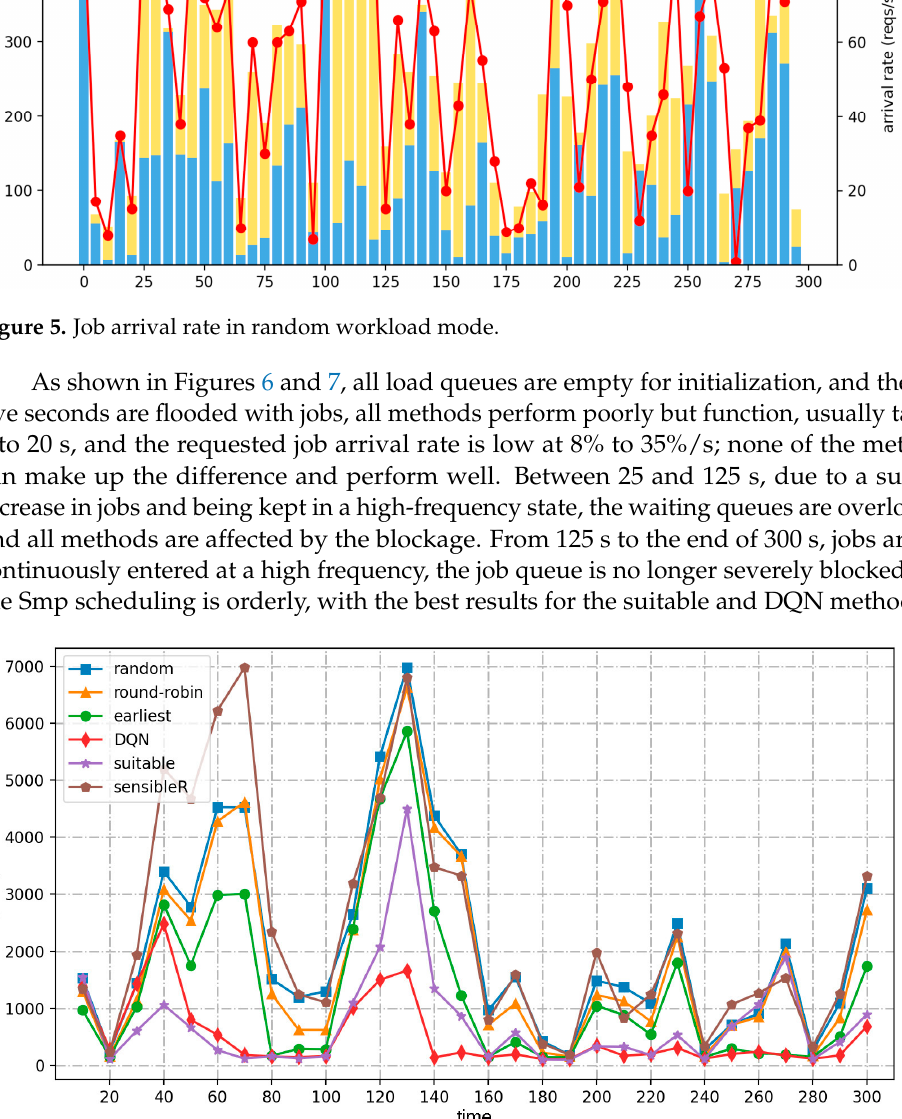
Figure 7. QoS s atisfaction in random workload mode. 5.3.2. Low-Frequency Workload Mode A low-frequency workload mode was set to test the algorithm’s performance in the Smp’s most common low-frequency idle usage scenarios. As shown in Figure 8, the job arrival rate for the low-frequency workload model was randomly generated in the range of [20,40] with a mean of 30.07% and a standard devia- tion of 6.36%. Combined with the low-frequency load pattern shown in Table 5, several algorithms perform well in the low-frequency state, with generally low average response times, high QoS satisfaction, and low load balancing. The suitable method achieves the lowest aver- age response time and the best performance; DQN has the lowest cost. As shown in Figure 9, after the initial 40 s training period, the DQN method gradually exceeds the average response time of all methods except the suitable method. Then, it runs smoothly close to the best-performing suitable method. As shown in Figure 10, the QoS satisfaction of the six methods in the low-frequency mode fluctuates only slightly for the sensible method, and the overall performance is good.